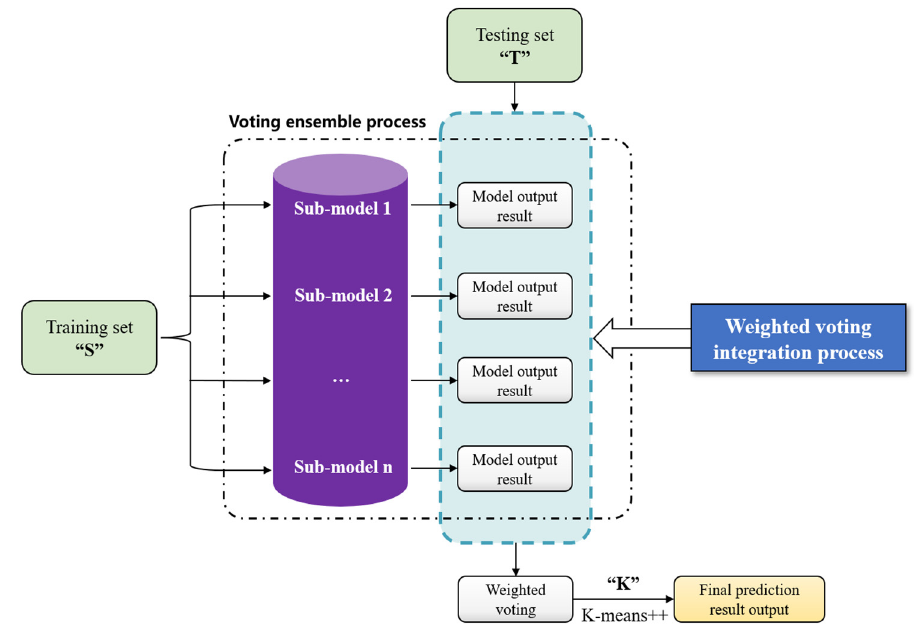
Figure 6. Schematic of the voting-ensemble method.